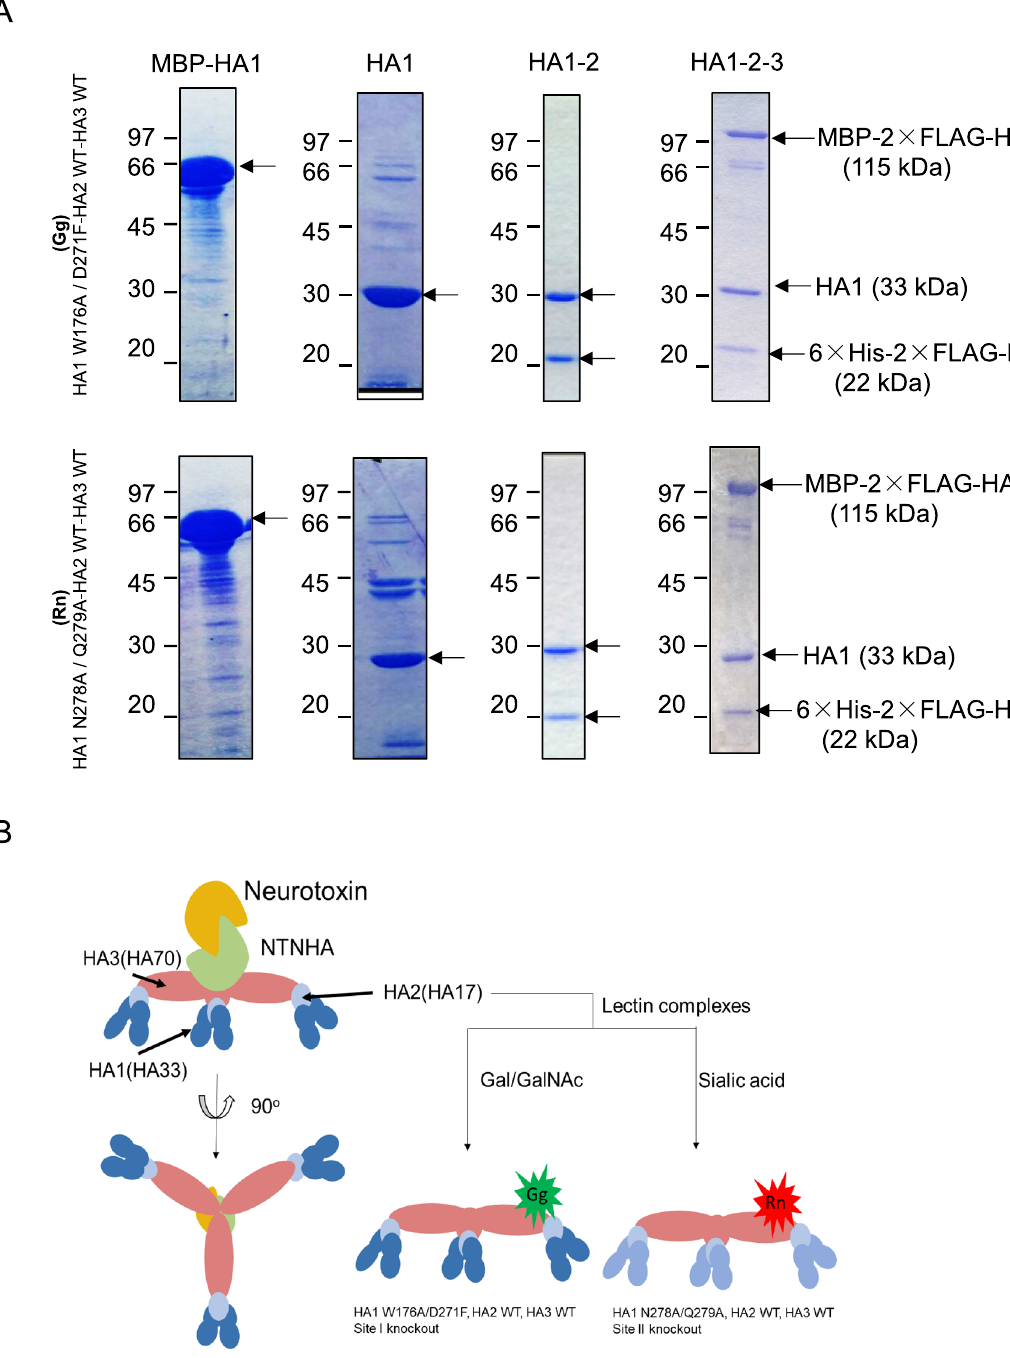
Figure 1. Preparation of HA1-2-3 lectin complexes. ( A ) Proteins obtained at each step of purification were developed on SDS-PAGE. MBP-HA1 lanes shows purified MBP-2xFLAG-HA1 (W176A/D271F (upper), N278A/Q279A (bottom)) used for complex preparation, target protein is indicated by arrows. HA1 lane shows HA1 after MBP tag cleavage (arrow). HA1-2 lane shows HA1-2 complex purified using Ni–NTA affinity chromatography. HA1-2-3 lane shows HA1-2-3 complex after final purification steps. Arrows indicate the bands of proteins MBP-2XFLAG-HA3, HA1, and FLAG-tagged HA2. ( B ) Schematic diagram showing the two lectin complexes